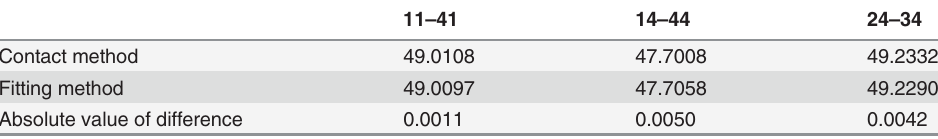
Table 1. Measurement values and differences of the three pairs of reference center points (unit: